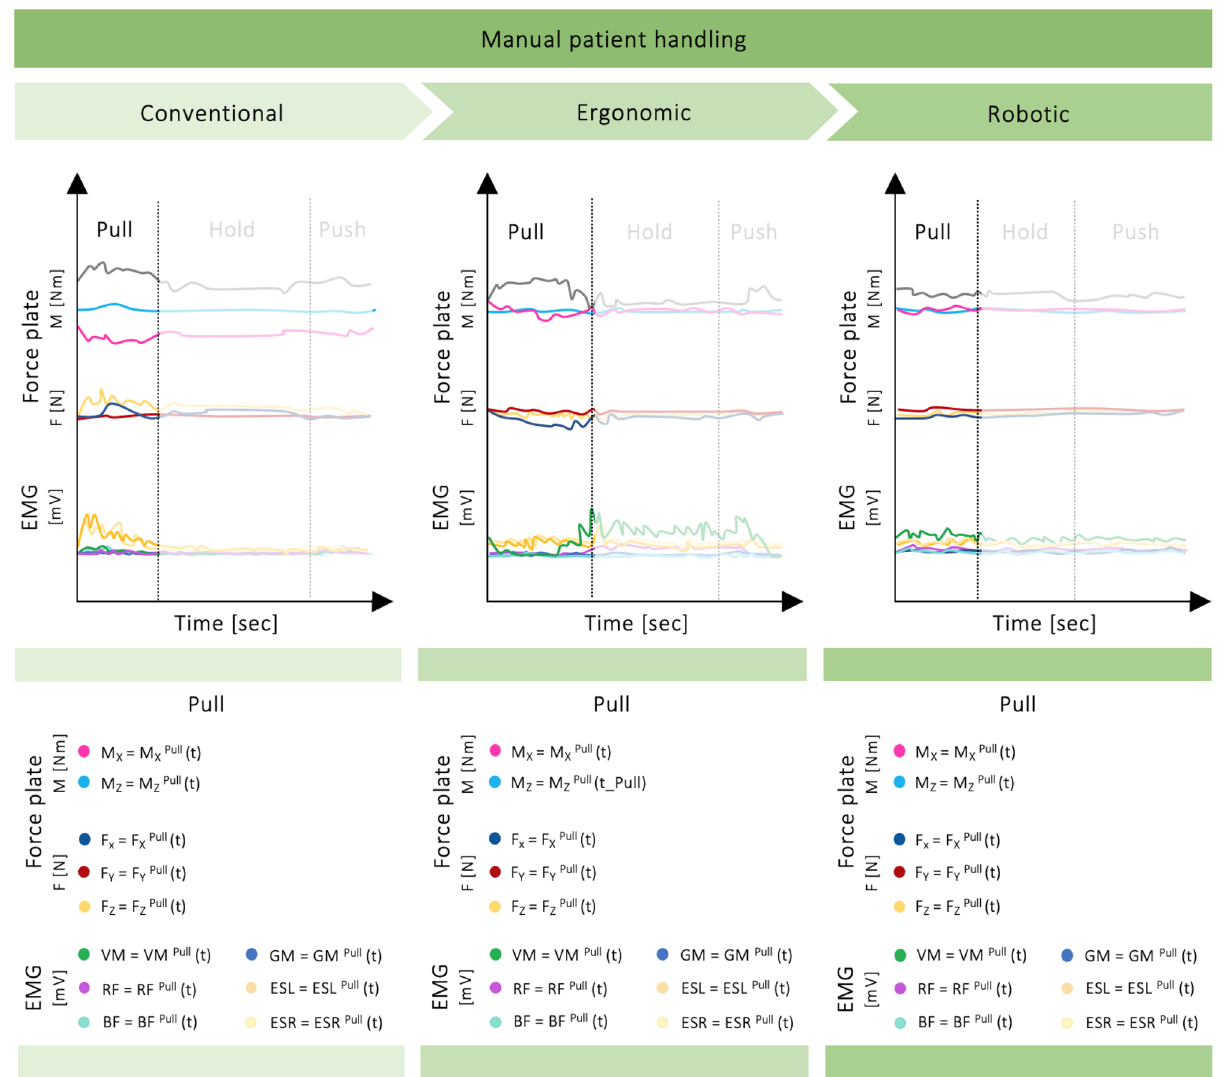
Figure 4. Schematic representation of data collection and processing for the manual patient handling tasks. The ground reaction forces (F X , F Y , F Z ), force plate moments (M X , M Z ), and EMG data (VM, RF, BF, GM, ESL, ESR) to be analyzed are visualized for the respective phases of the tasks conducted. Three different manual